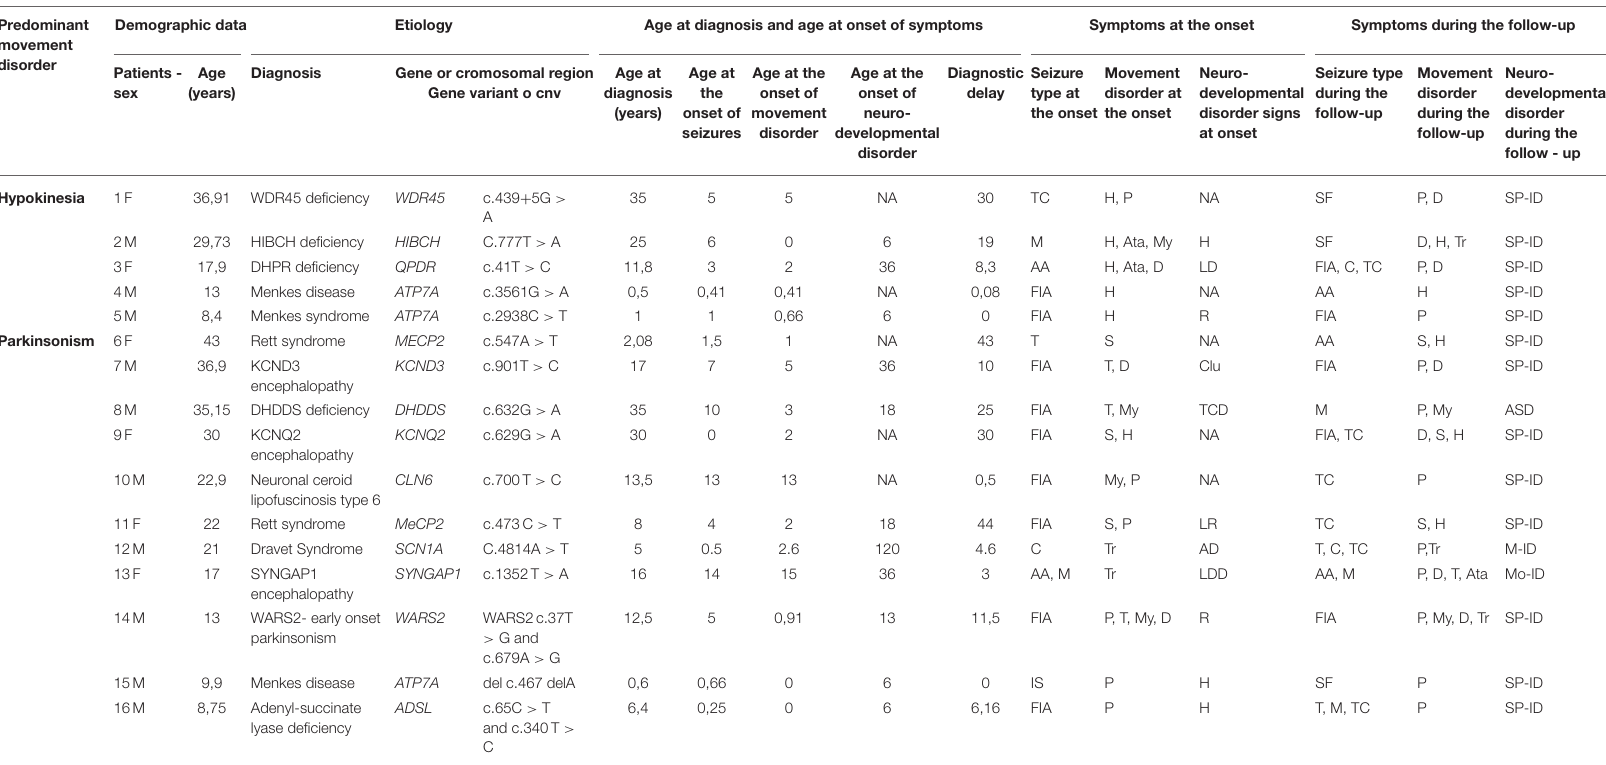
TABLE 2 | Demographic, clinical, and molecular genetics features of patients with developmental encephalopathies presenting with epilepsy and hypokinetic movement disorders (Group B). Predominant